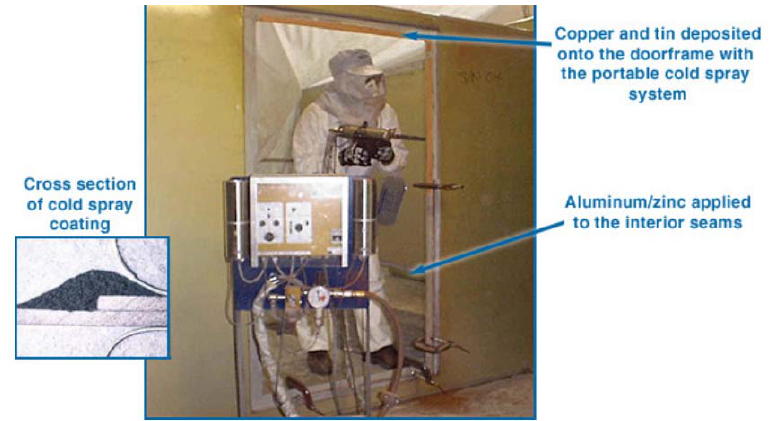
Figure 2: an example of the CGDS applications